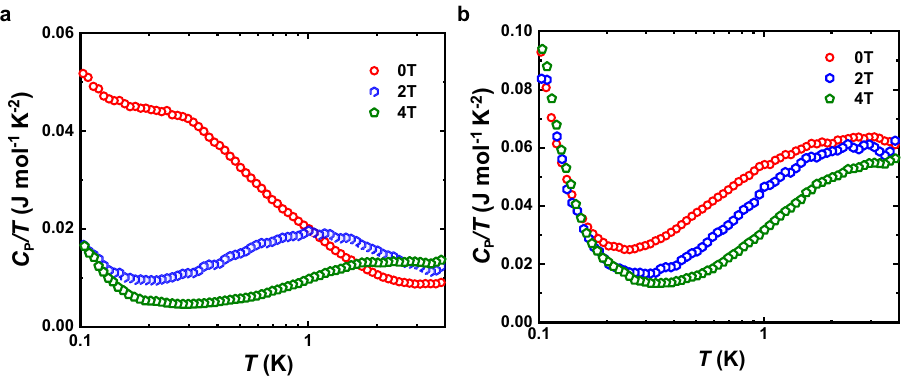
Fig. 6 Low-temperature speci fi c heat capacities of TiRu 1 + x Sb. a TiRu 1.2 Sb. b TiRu 1.5